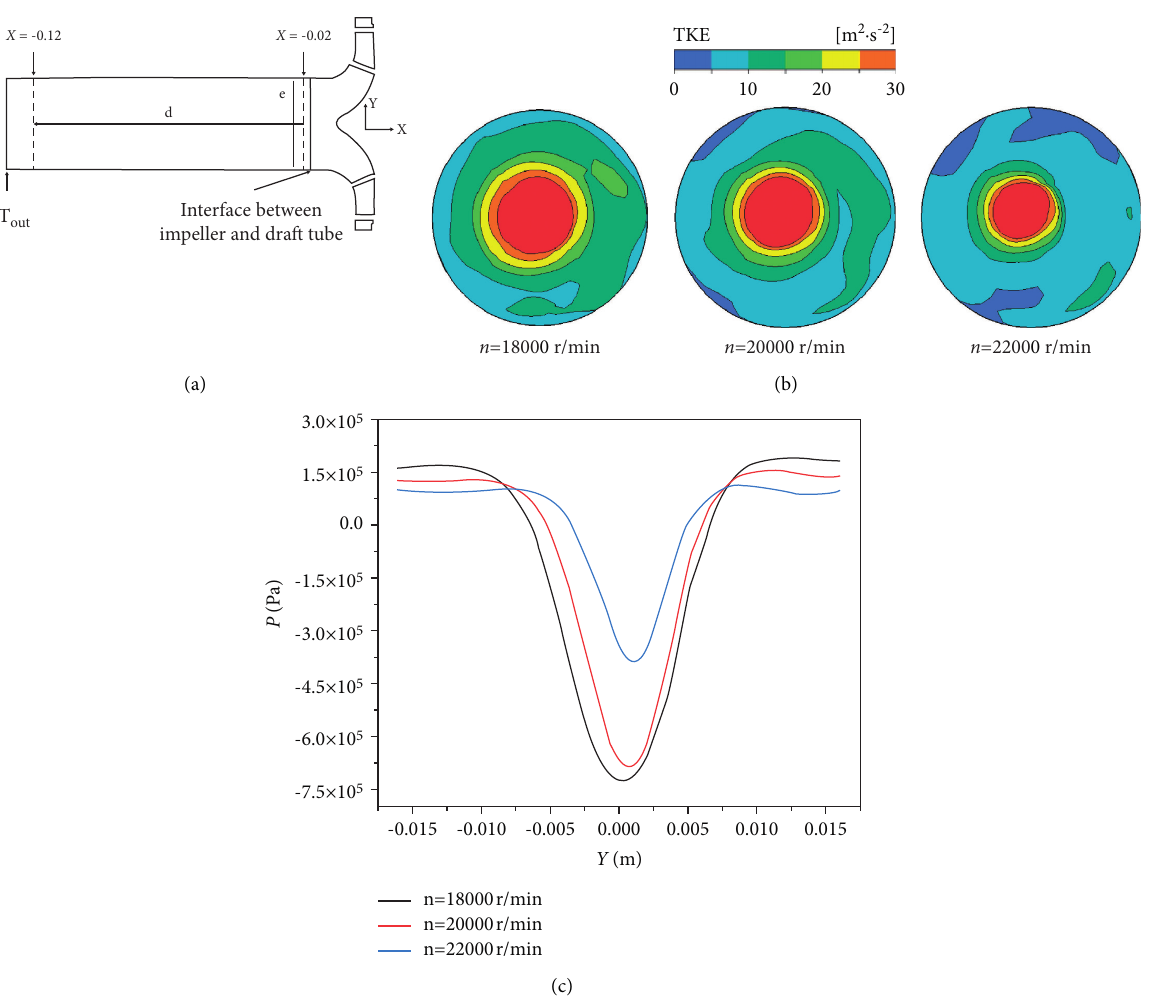
Figure 17: Velocity and radial pressure distribution at draft tube inlet. (a) Axial projection diagram of impeller-draft tube. (b) Distribution of the TKE near draft tube inlet. (c) Radial pressure distribution at draft tube